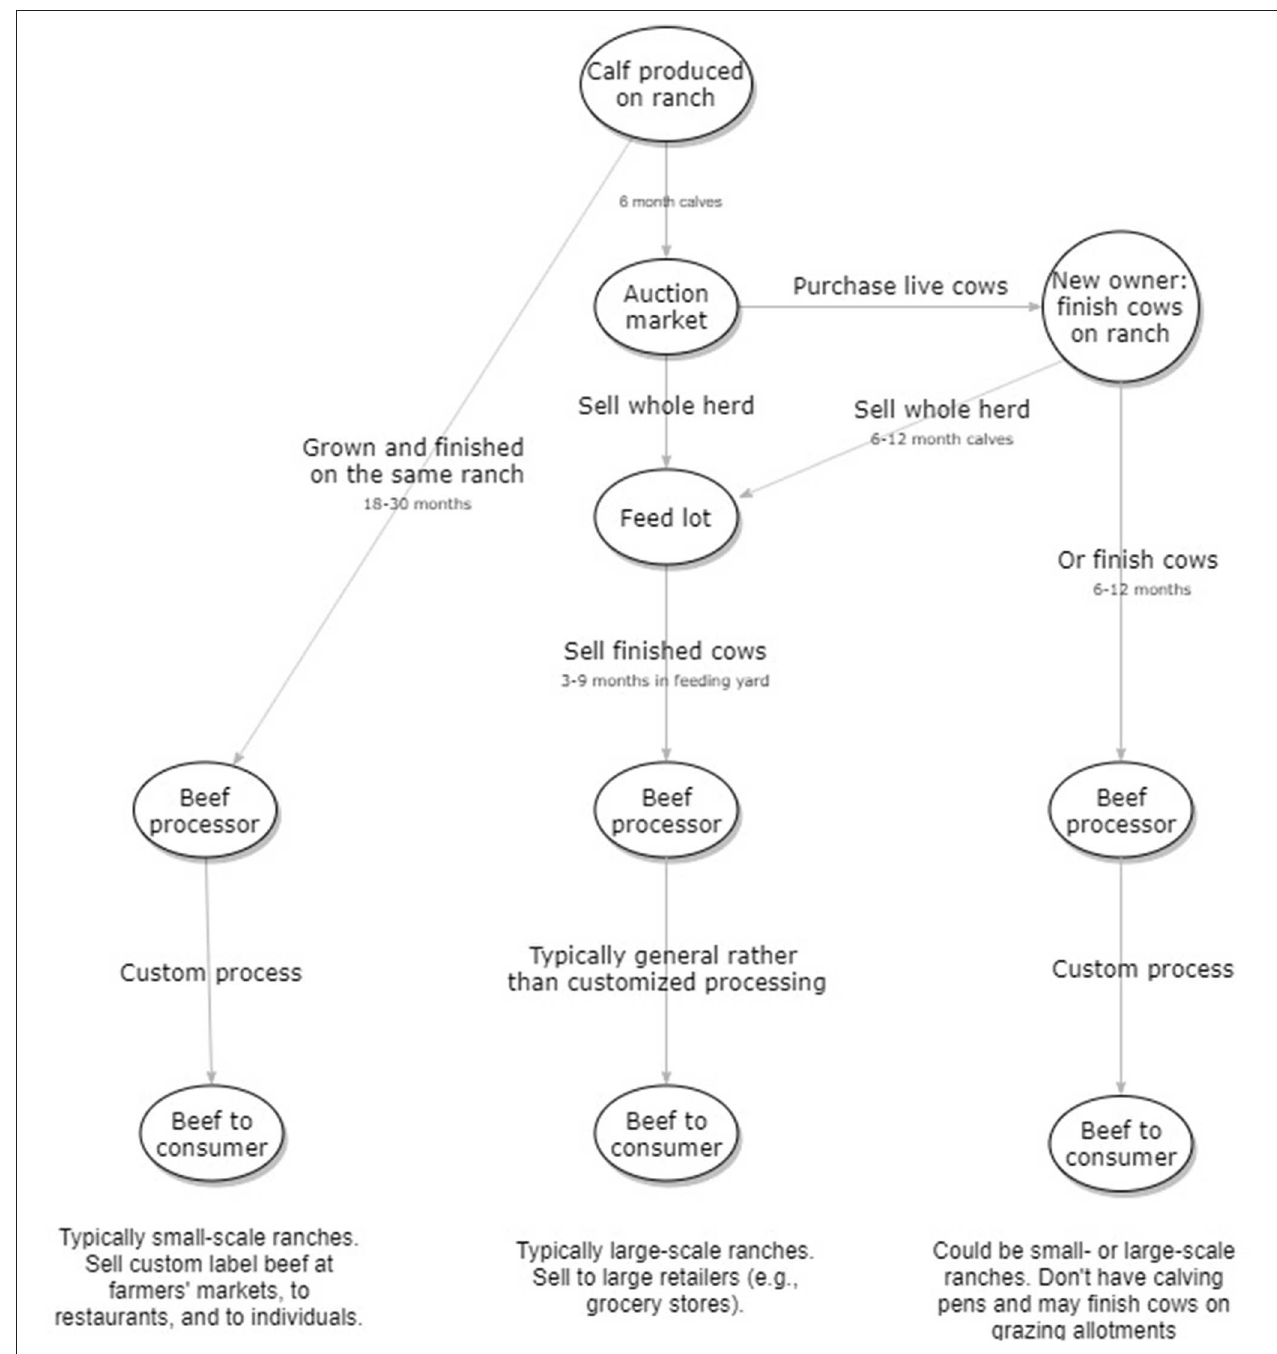
FIGURE 1 | Illustration of three alternative cow-to-beef lifecycles followed by the beef industry.